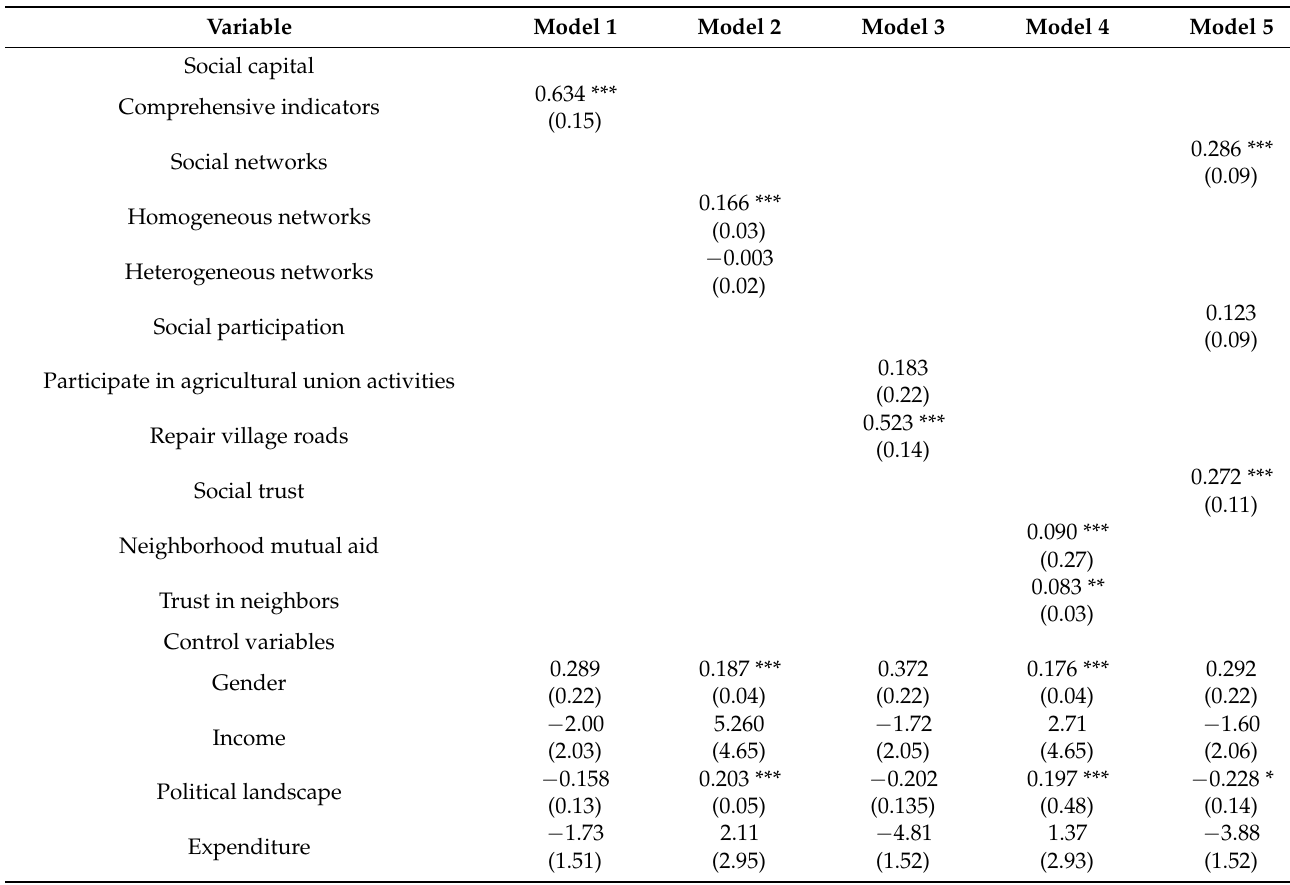
Table 2. The impact of social capital on farmers’ willingness to adopt new agricultural